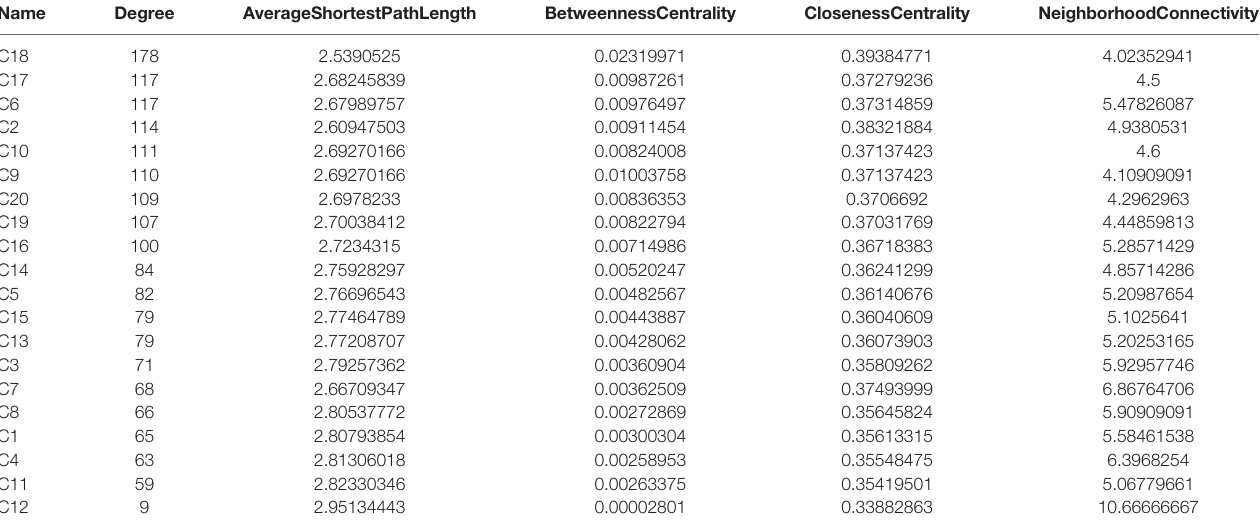
TABLE 3 | Degree of 16 active components analyzed by